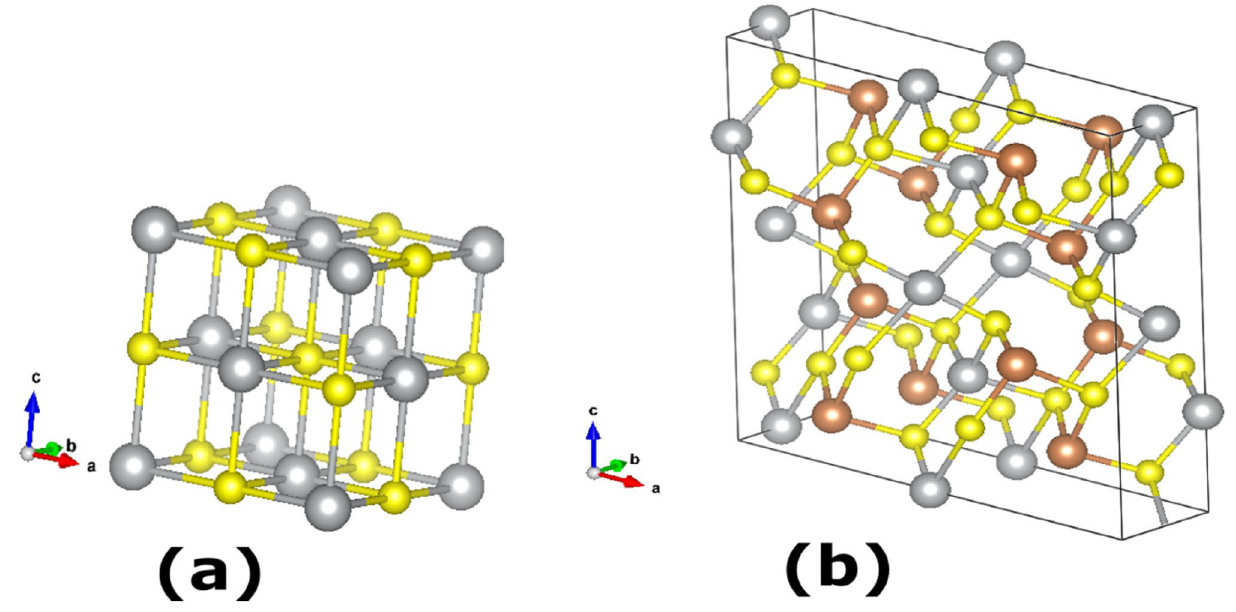
Figure 1. ( a ) Crystal structure of cubic cuboargyrite β-AgSbS 2 as reported by Geller and Wernick, with the silver and antimony indistinguishable 33 . ( b ) Crystal structure of monoclinic α-AgSbS 2 miargyrite as obtained by Smith 34 ; silver atoms (Ag) are represented by silver spheres, Antimony (Sb) by brown spheres and S by yellow